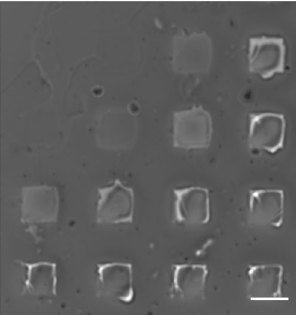
Fig. 6 Bright fi eld image of HA-am hydrogel exposed with a dose of 6.9 J/cm 2 through a photomask with 200 × 200 µm 2 openings. Topo- graphical effects are observed in the areas exposed to the UV light. Scale bar 200 µm